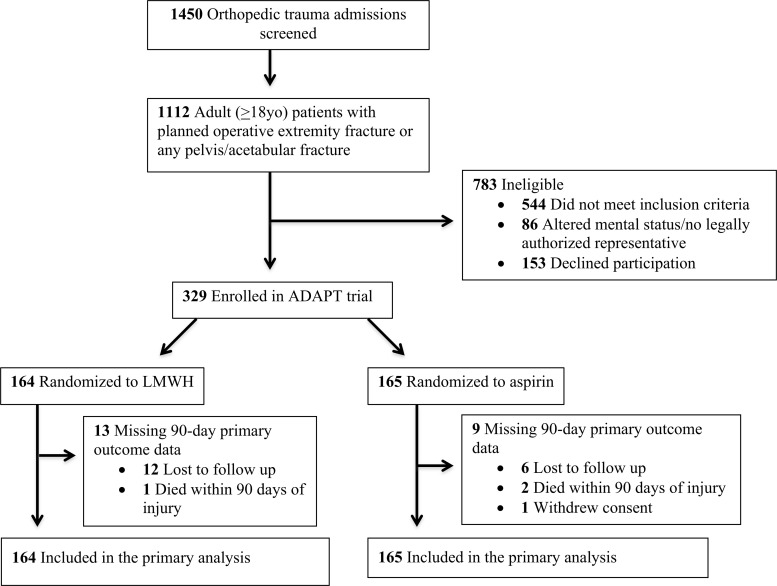
CONSORT diagram.